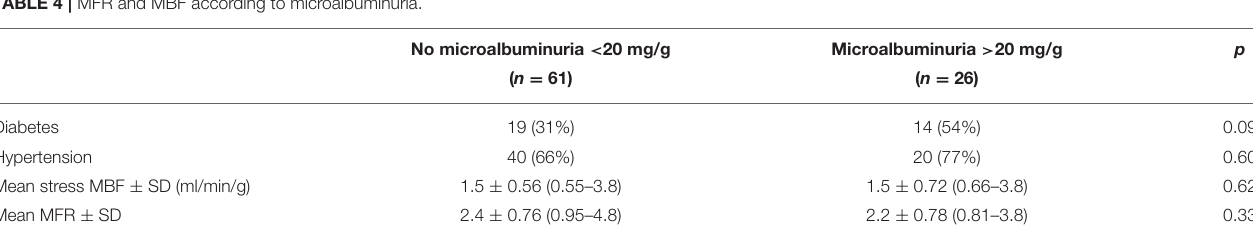
TABLE 4 | MFR and MBF according to